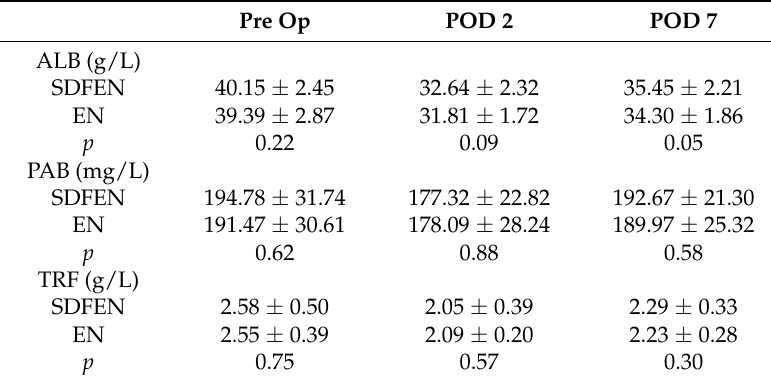
Table 3. Comparison of the two groups’ nutrition